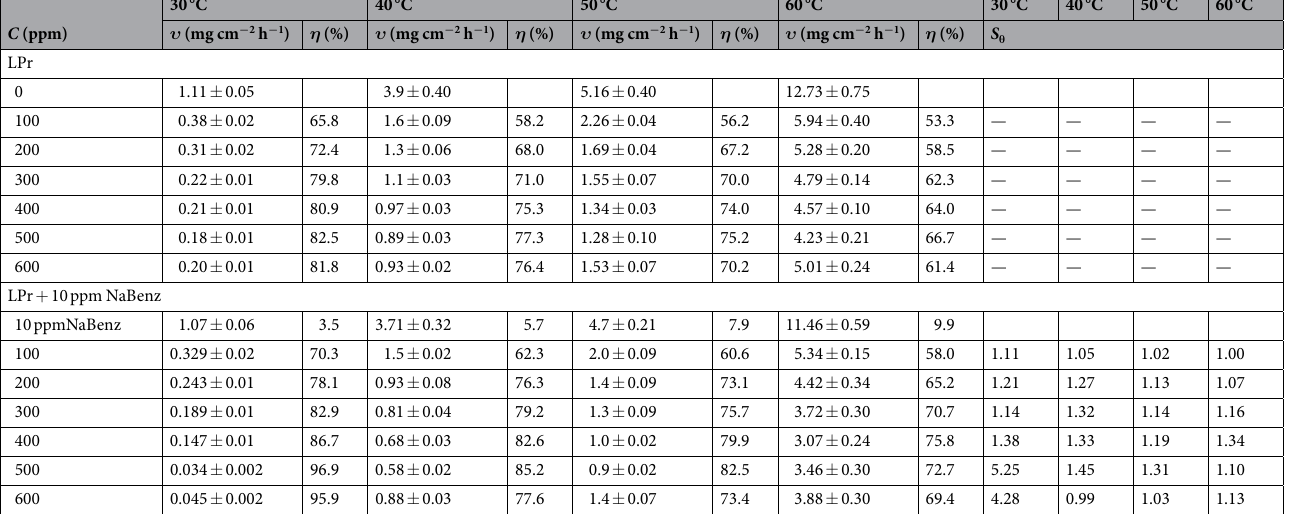
Table 3. Corrosion parameters for MS in 1M HCl solution in the absence and presence of different